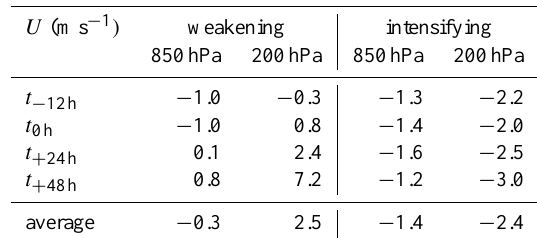
Table 2. The average zonal wind ( U ) for the weakening and inten- sifying cases at different